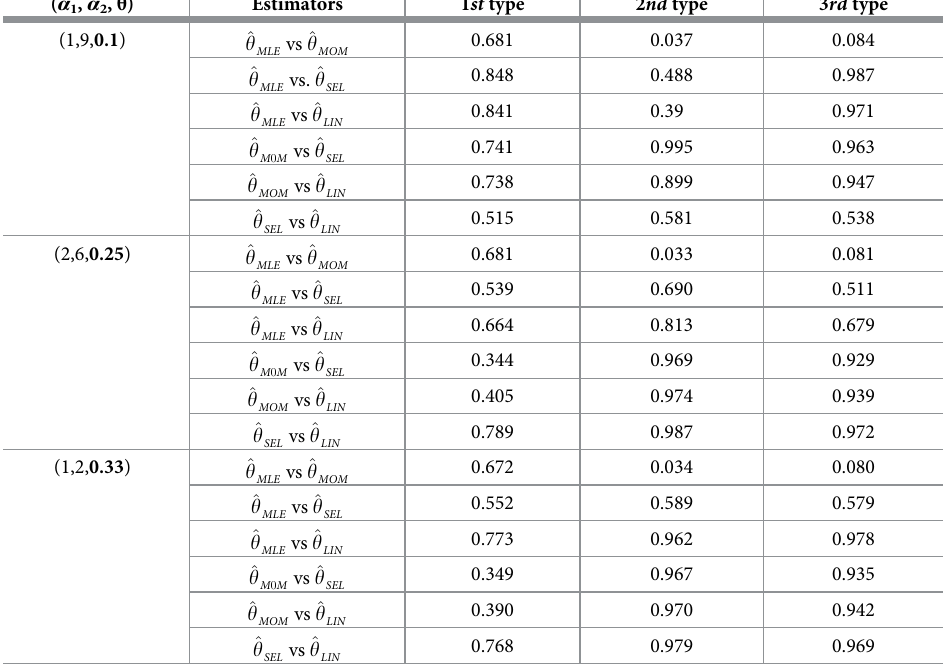
Table 4. PN comparisons based on progressive type II censoring based on three types of censoring with theoretical value of θ < 0.5.